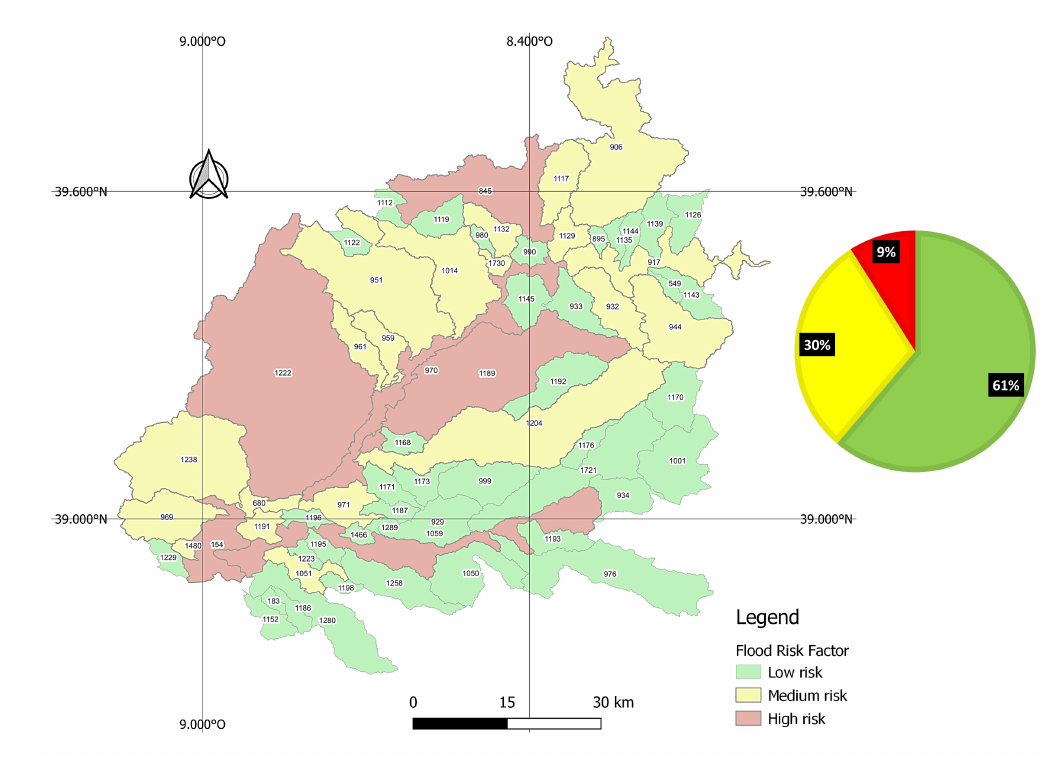
Figure 5. Distribution of the flood risk in the case study.